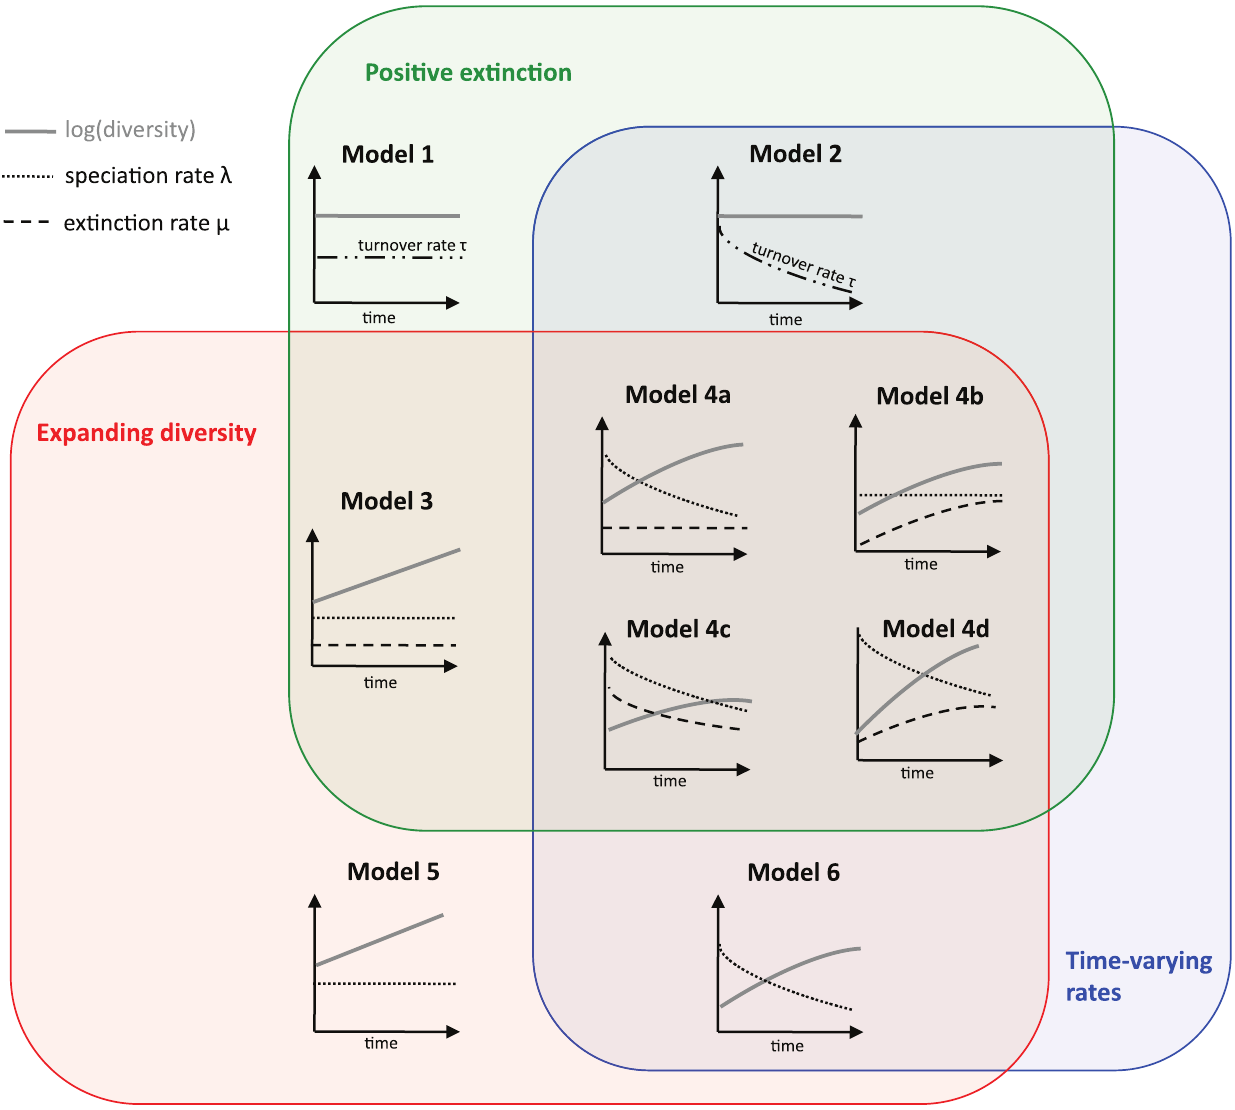
Figure 1. Models of diversification. Schematic illustration of the nine diversification models considered in our analyses. The models can be classified according to three broad criteria: diversity is either expanding over time (in red, Models 3–6) or saturated (Models 1 and 2); rates either vary over time (in blue, Models 2, 4a–4d, and 6) or they are constant over time (Models 1, 3, and 5); and extinctions are either present (in green, Models 1– 4) or absent (Models 5 and 6). There are four flavors of models that exhibit expanding diversity with time-varying rates and positive extinction: the speciation rate ( l ) varies over time while the extinction rate ( m ) is constant (Model 4a); the extinction rate varies over time while the speciation rate is m ; Model 4c); and both rates vary independently over time constant (Model 4b); both rates vary over time with a constant extinction fraction ( e ~ l (Model 4d). When they vary, rates either decay or grow exponentially. The parameters of each model are shown in Table 1.